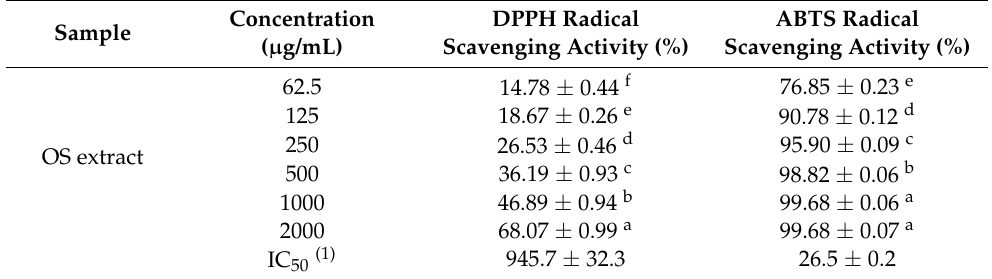
Table 3. DPPH and ABTS radical scavenging activities of A. cepa skin (OS)